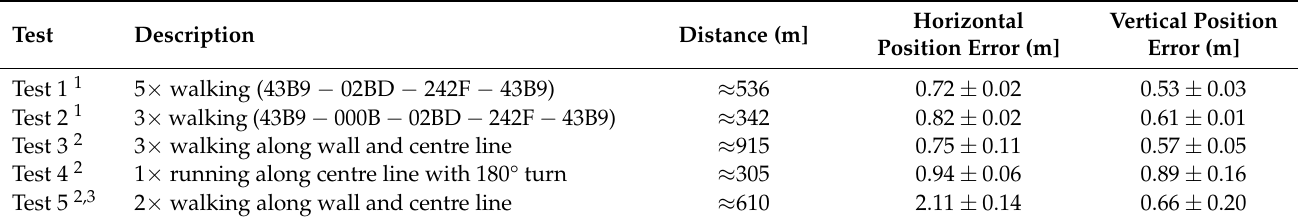
Table 4. Estimated positioning error expressed in terms of average root-mean-squared error (ARMSE) determined by 10 repetitions. For Tests 1–4, a full anchor configuration is